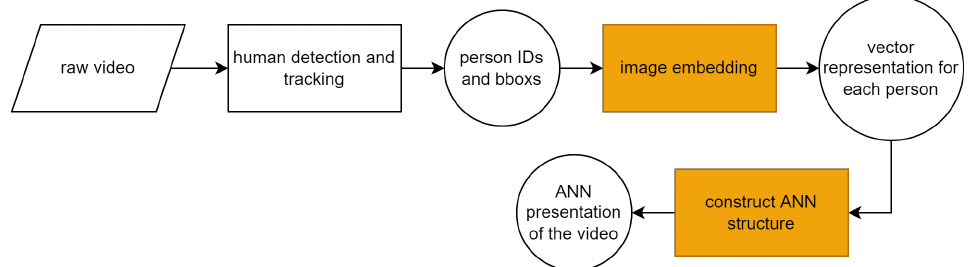
Figure 3. The proposed pipeline for indexing a video for a fast person description search. The rectan- gles represent a process, and the circles represent data. The first step in the pipeline is to perform person detection and tracking. The output of this step is a list of detection results that consists of object IDs and bounding boxes for each frame. If the object is considered to be the same person across multiple frames, the corresponding bounding boxes are given the same ID. The tracking result is then processed and the image of each person is extracted from the video. We choose the box that has the median size to be the representative image of each person. Each image is then embedded with the image branch of the model, and finally, the embedding vectors are used to construct an ANN structure. Each ANN object is the “index” for a